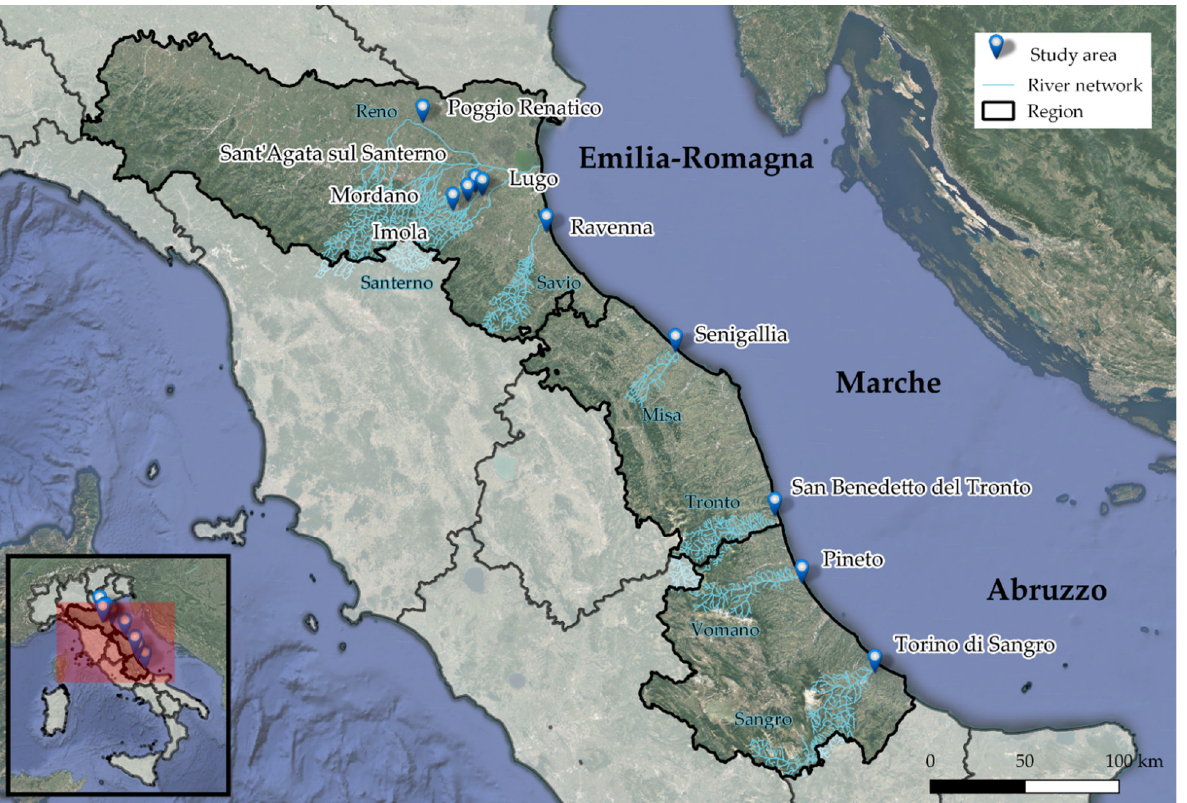
Figure 1. Location of the 10 study areas located in the Emilia-Romagna, Marche, and Abruzzo Regions (central Italy). Table 1. List of the study areas identified by region, municipality (district), and code. Each site has been linked to the most impacting type of floods, activities implemented by the project, and number of survey respondents. The types of floods are listed in order of importance. The implemented flood risk reduction activities are listed per type (i.e., civic adaptation plans, workshops, alert simulations, theatrical plays) and number of involved citizens. The number of spectators in the theatrical play are estimated. The number of questionnaire respondents are divided in the ex-ante (EA) and ex-post (EP) phases.